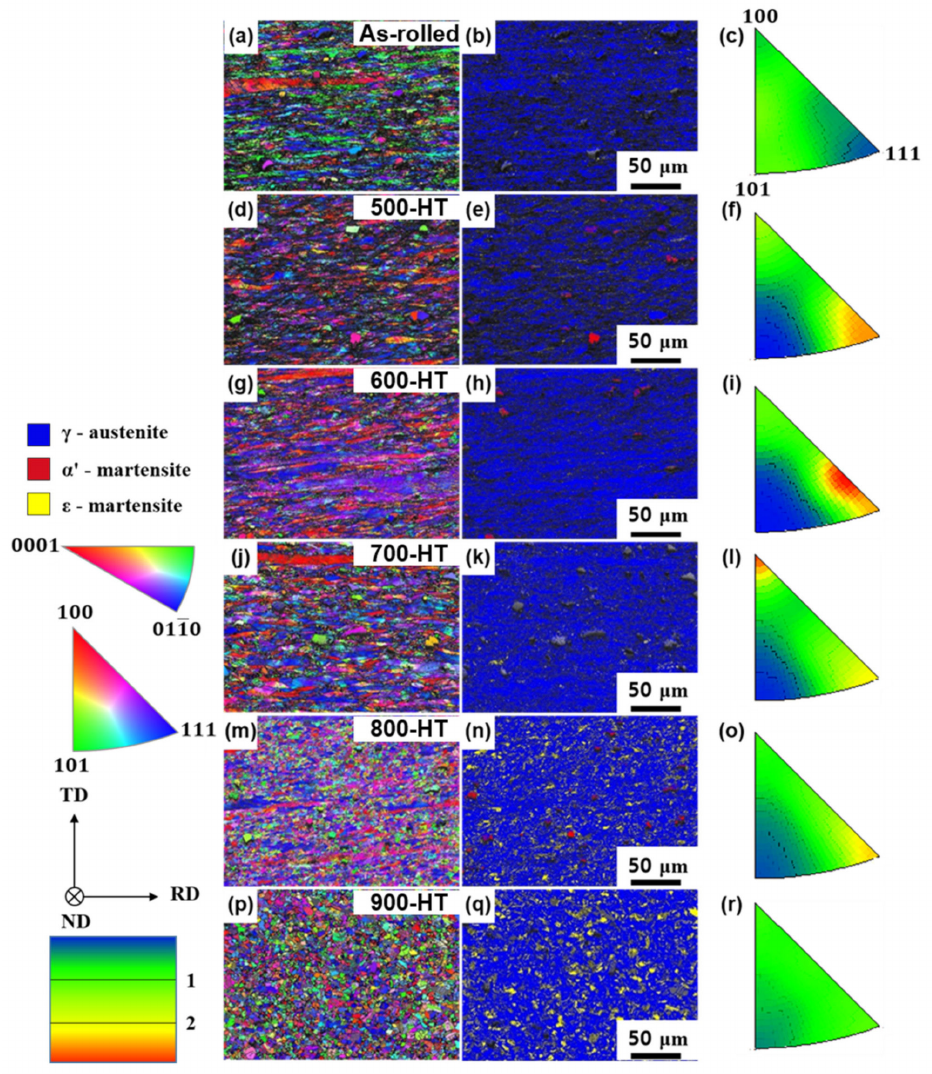
Figure 5. ( a , d , g , j , m , p ) Electron backscatter diffraction (EBSD) rolling direction (RD) inverse pole figure maps, ( b , e , h , k , n , q ) phase maps, and ( c , f , i , o , r ) RD pole figures; ( a–c ) as-rolled, ( d–f) 500 ◦ C heat-treated, ( g–i ) 600 ◦ C heat-treated, ( j–l ) 700 ◦ C heat-treated, ( m–o ) 800 ◦ C heat-treated, and ( p–r ) 900 ◦ C